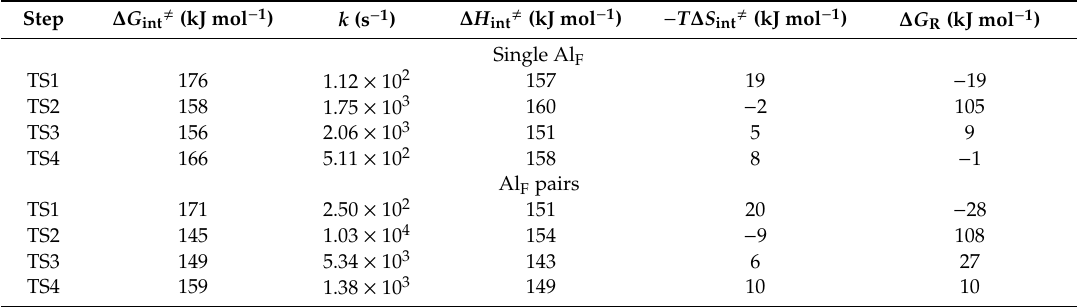
Table 6. Calculated free energy barriers ( ∆ G int (cid:44) ), rate constants ( k ), enthalpy barriers ( ∆ H int (cid:44) ), and entropy losses ( − T ∆ S int (cid:44) ), as well as reaction free energies ( ∆ G R ) at 823 K for each reaction step in the formation of benzene in the transition period for propane aromatization over